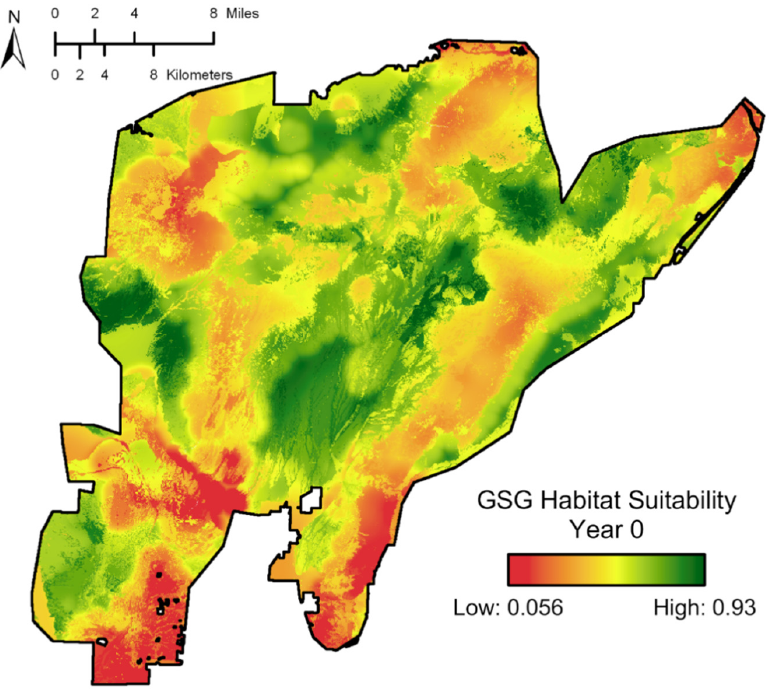
Figure 5. Current (year 0) habitat suitability index for GSG in the Black Mountains based on 2013 five-meter RapidEye satellite imagery. Average habitat suitability for year 0 of simulation was 50.5%. At year 0, there is no difference among management scenarios. Darker green indicates higher habitat suitability index, and redder indicates poorer habitat suitability index.